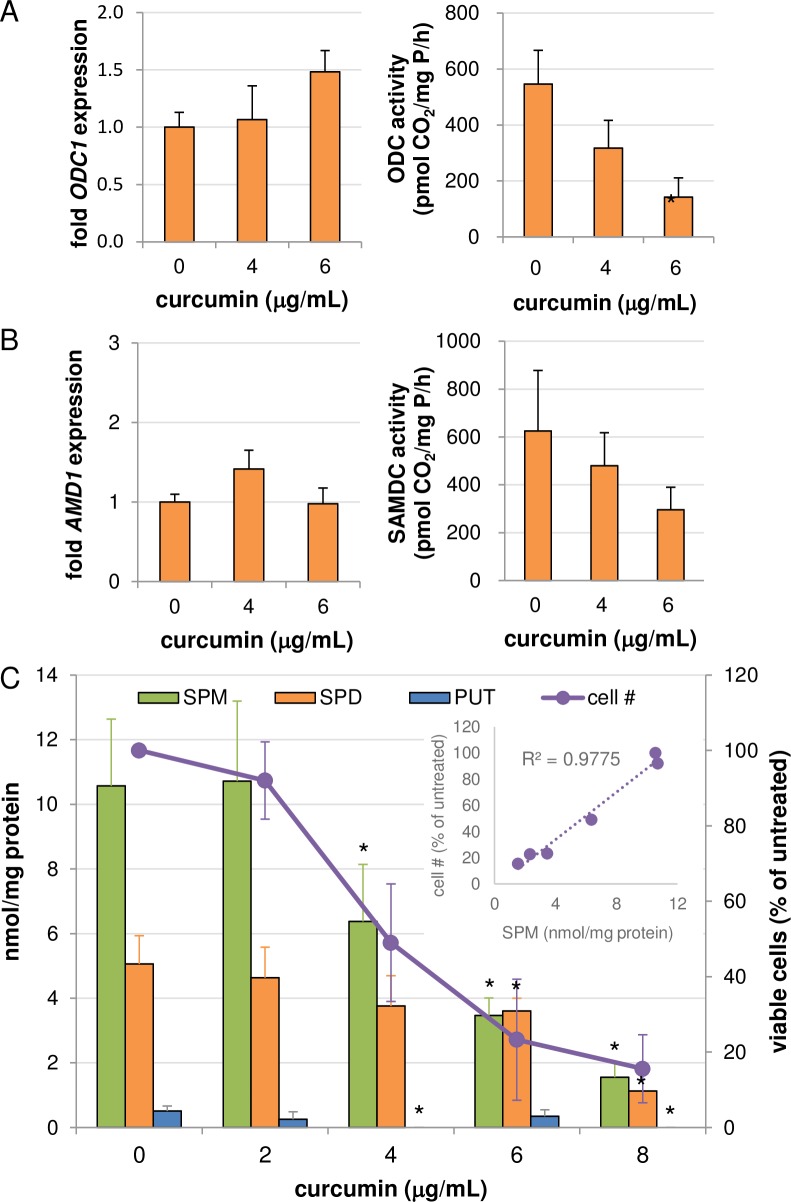
Effects of curcumin on polyamines and their biosynthetic enzymes in AGS cells.AGS gastric carcinoma cells were treated for 48 h with curcumin followed by analyses of mRNA expression and enzyme activity levels of the polyamine biosynthetic enzymes ODC (A) and SAMDC (encoded by the AMD1 gene) (B). (C) Curcumin decreased intracellular polyamine pools and inhibited growth of AGS cells (SPM: spermine; SPD: spermidine; PUT: putrescine). (Inset) Linear regression of spermine concentration versus % of viable cells remaining relative to untreated cells in response to increasing doses of curcumin (p < 0.001). Graphs depict the means of data collected from at least 2 separate biological experiments, each measured in triplicate (duplicate for HPLC), with error bars indicating standard error of the mean. *p < 0.05 relative to untreated.